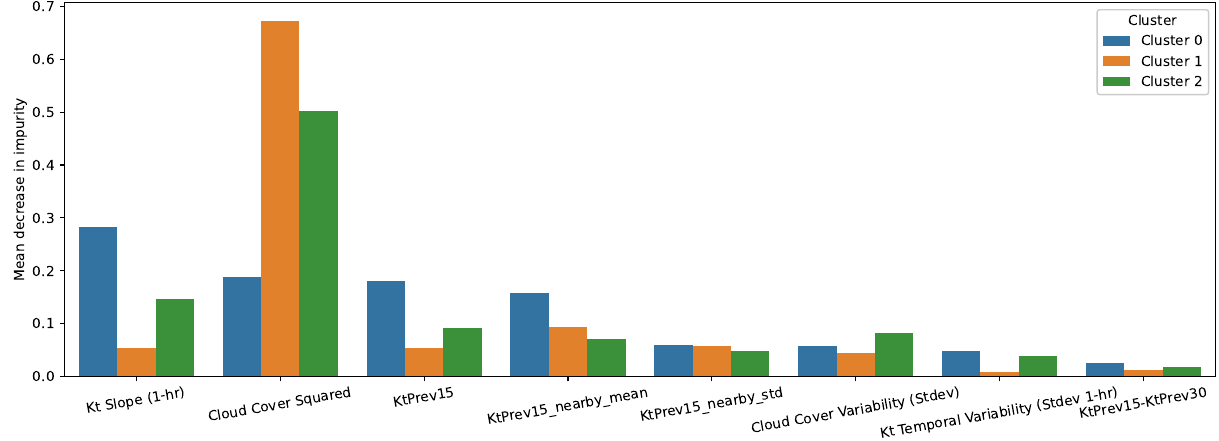
Figure 10. Cluster-specific best features in terms of mean decrease in impurity.